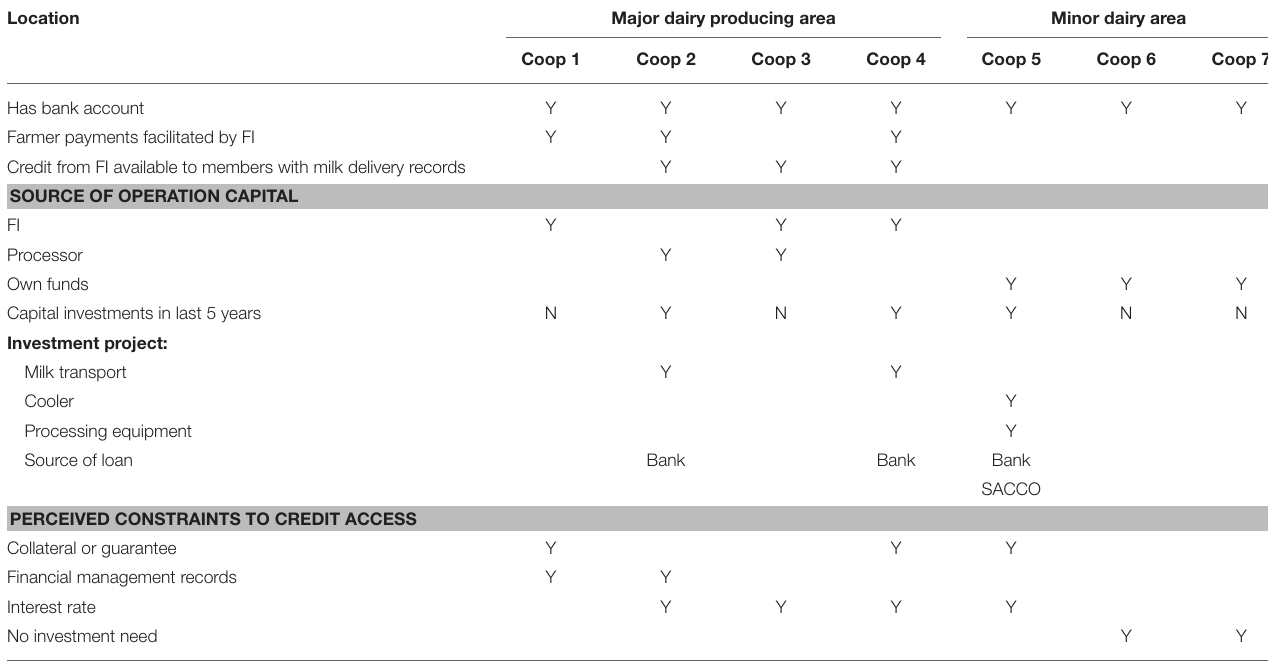
TABLE 4 | Financial relationships and investments by selected cooperatives (2015).